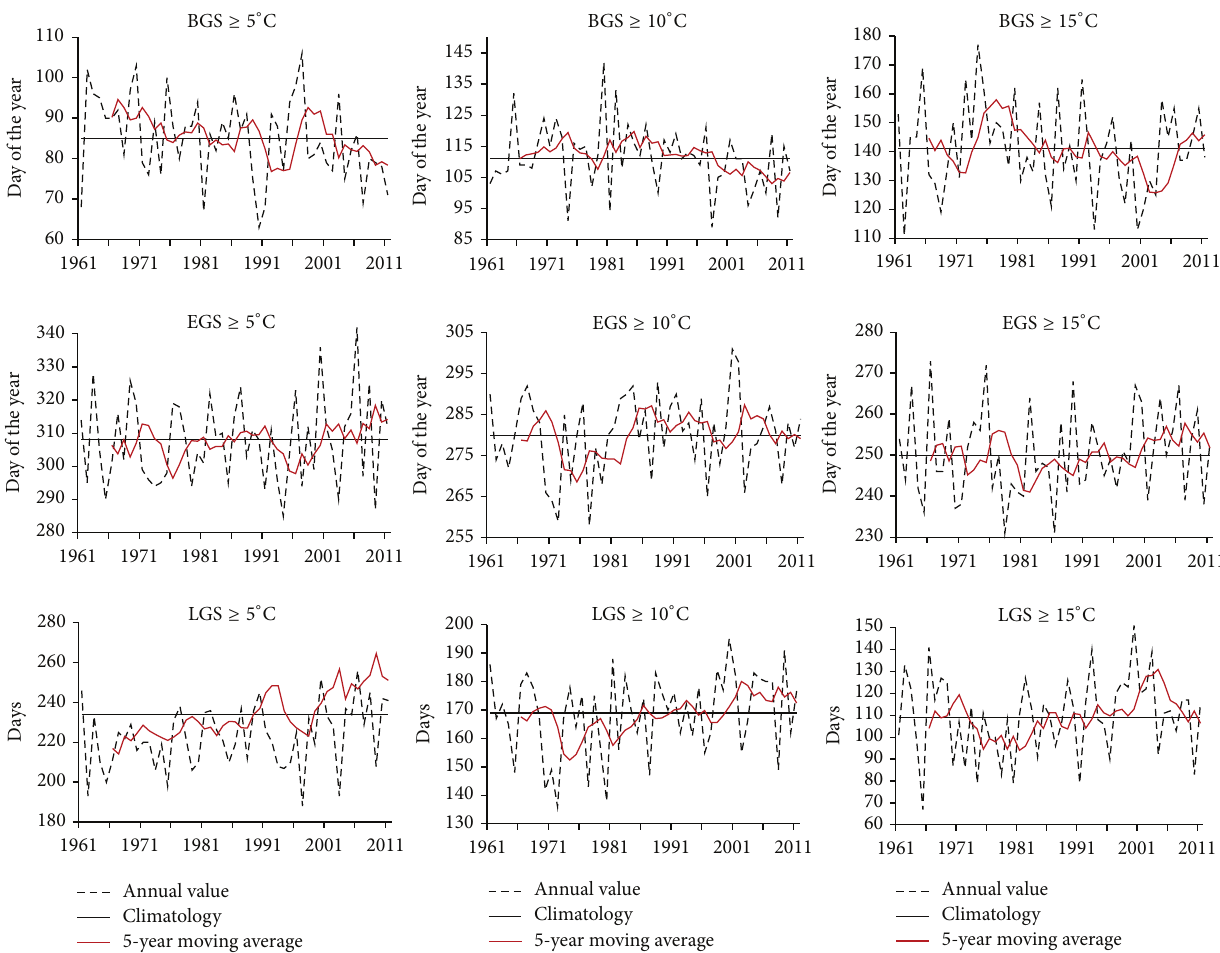
Figure 3: Interannual variations of area-averaged BGS (beginning of the growing season), EGS (end of the growing season), and LGS (length of the growing season) for the 5, 10, and 15 ∘ C temperature thresholds from 1961 to 2011 in the Elbe River lowland. The black line indicates the climatology of each event (average), and the grey line indicates the 5-year moving average of each